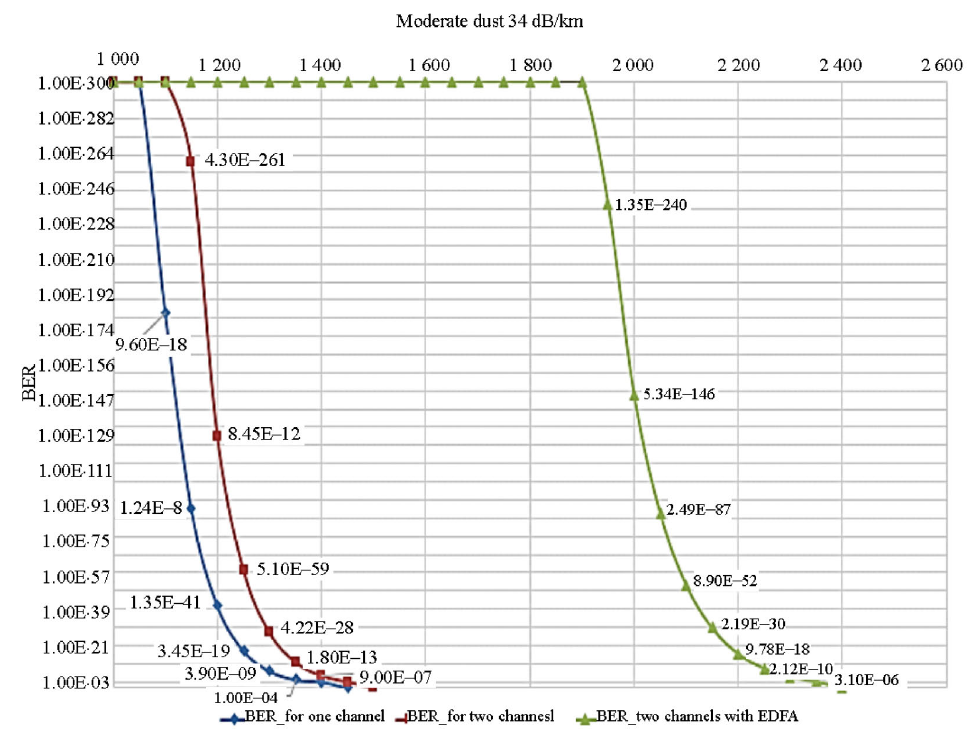
Fig. 7 BER performance comparison according to the distance at 34 dB/km.